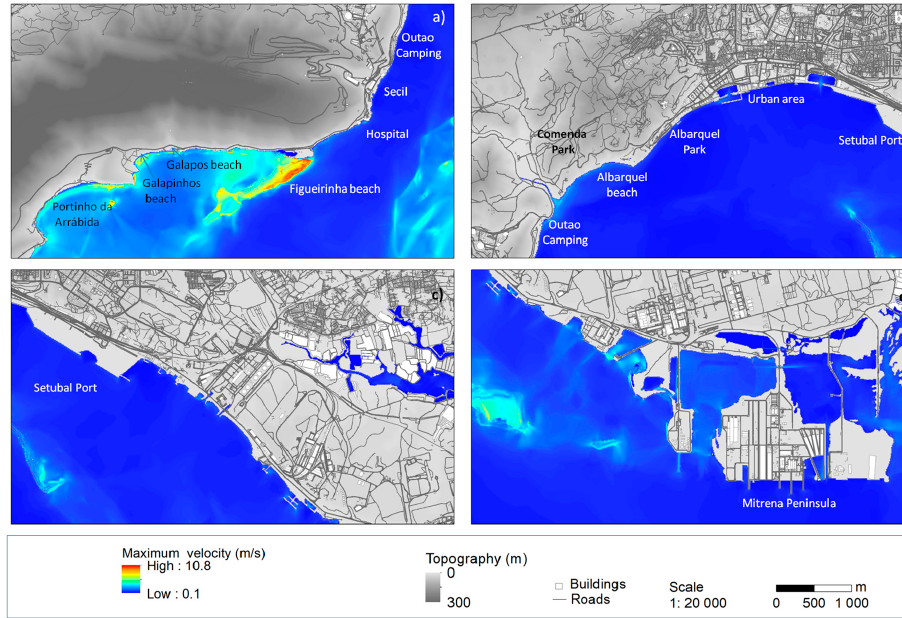
Figure 9. Maximum velocity of the 1969 tsunami: ( a ) Western area; ( b ) Central area, including the urban area; ( c ) Eastern area, including the industrial area; ( d ) South-east area where the Mitrena Peninsula is located.